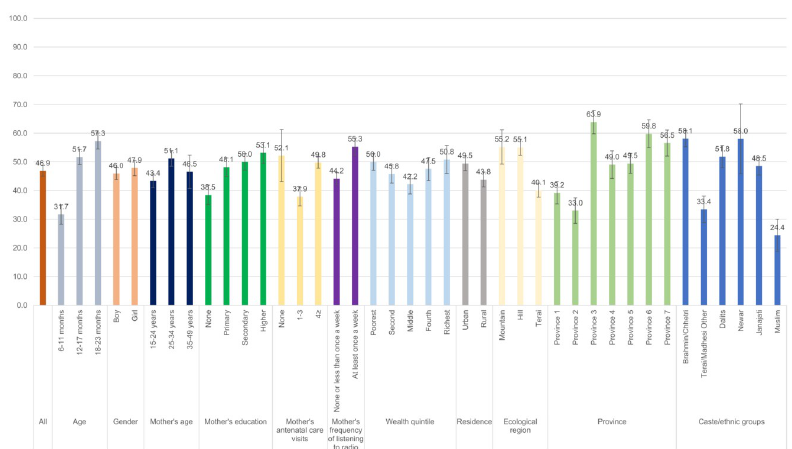
Fig 6. Percentage of Nepalese children aged 6 to 23 months consuming vitamin-A rich fruits and vegetables by sociodemographic factors.